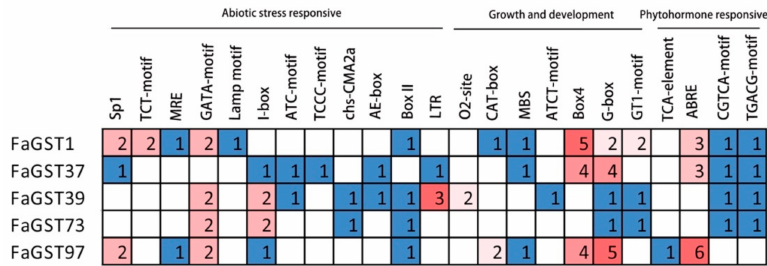
Figure 9. Cis -regulatory elements found in the putative anthocyanin-related FaGST genes. All the elements were classified into three groups involved in abiotic stress, growth, and development, and phytohormone responsiveness based on the functional